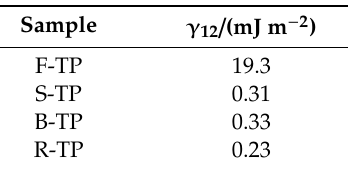
Table 8. Interfacial free energies.